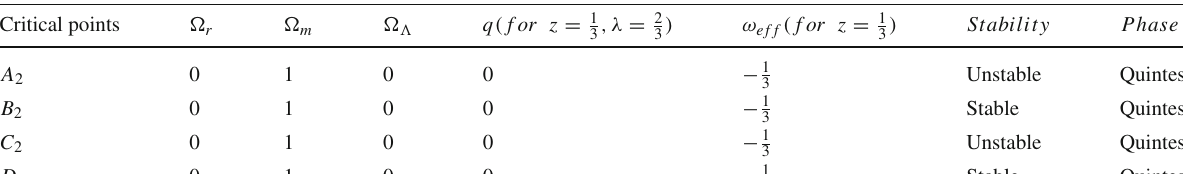
Table 8 Stability conditions, deceleration parameter, density parameters Critical points